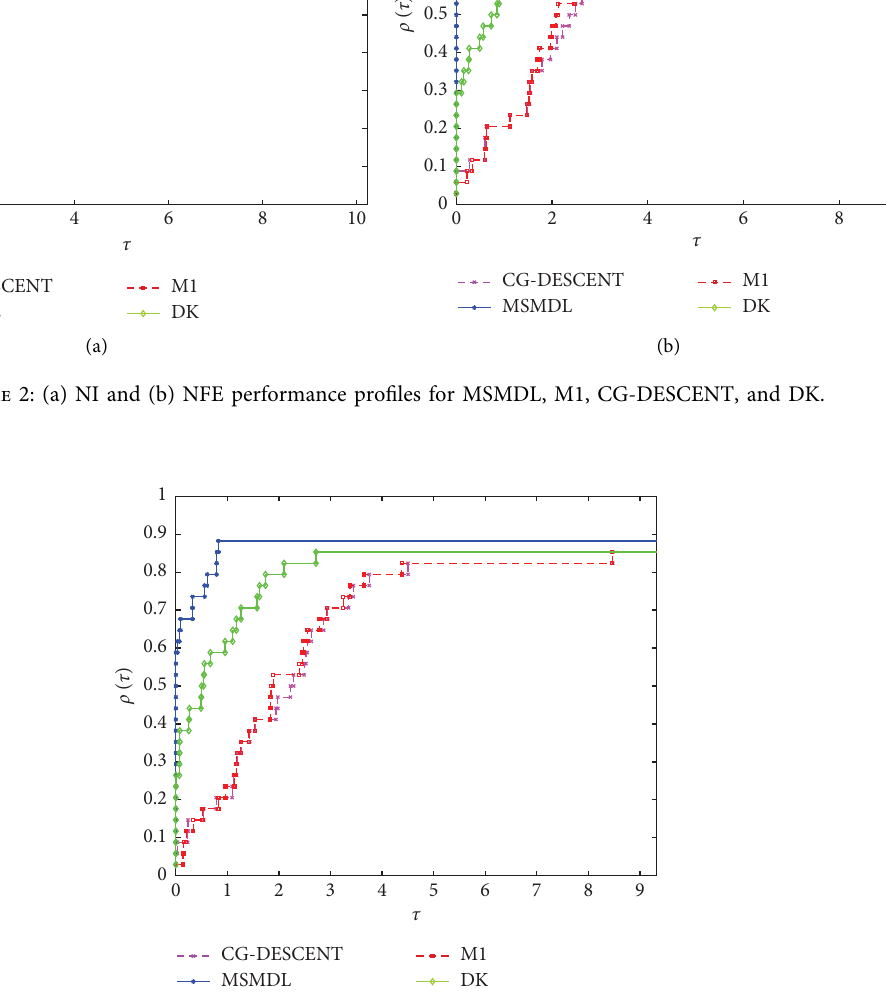
Figure 3: CPUts performance profles for MSMDL, CG-DESCENT, M1, and